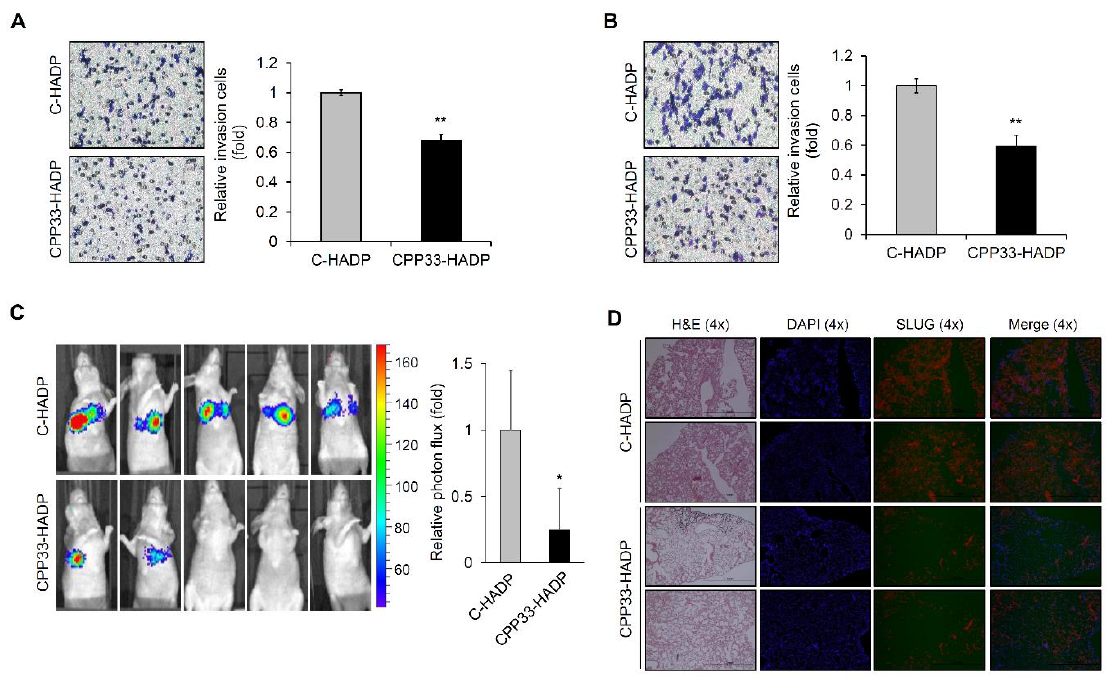
Figure 4. Synthetic peptide CPP33-HADP inhibits the invasion ability of NSCLC cells.